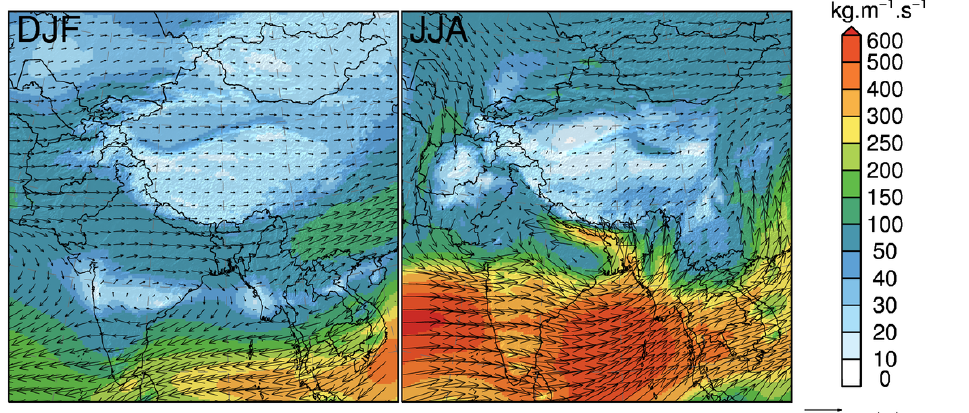
Figure 3. Decadal average of the vertically integrated water vapour flux (kgm − 1 s − 1 ) in DJF (left) and JJA (right) for HAR30. Colour shad- ing denotes strength of water vapour flux, arrows (plotted every sixth grid point) indicate transport direction (length of arrows is proportional to flux strength up to 200kgm − 1 s − 1 and is constant afterwards for more